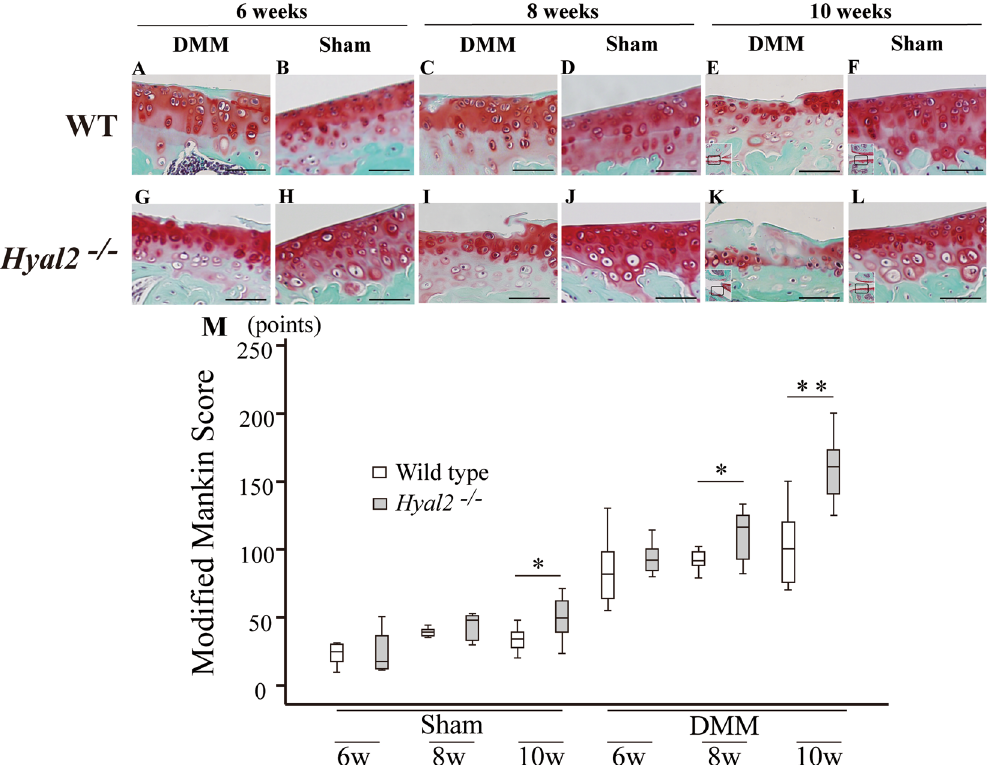
Figure 5. Histological findings of articular cartilage in DMM and sham treated WT and Hyal2 − / − mice. Safranin O staining of articular cartilage in sham treated (B, D, F, H, J, L) and DMM treated (A, C, E, G, I, K) mice. Bars depict 50 μ m in length. Modified Mankin score (M) of mice articular cartilage (n = 8 per group). * P < 0.05, ** P <